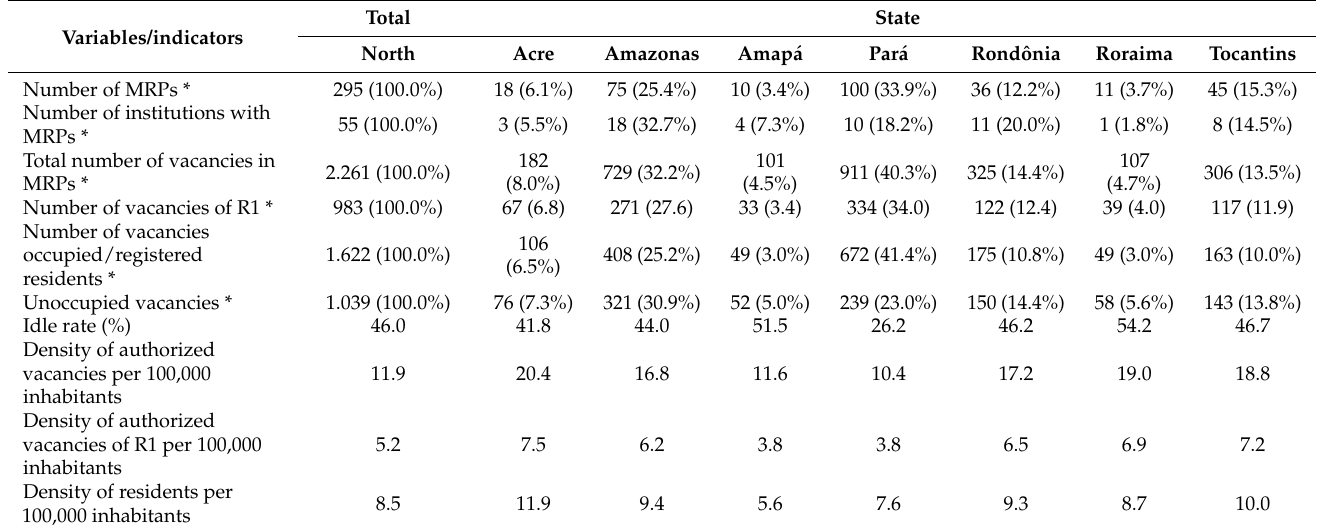
Table 2. Descriptive analysis of MRPs variables and indicators. North region, Brazil,